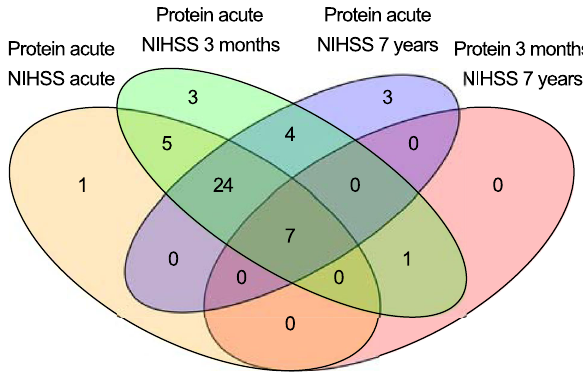
Figure 2. Protein level associations with stroke severity and neurological outcome at the different time points. Number of proteins with a statistically significant association (FDR < 0.05) between plasma levels and degree of neurological impairments according to the NIH stroke scale at the different time points, in linear regression models adjusted for age, sex, and time until blood